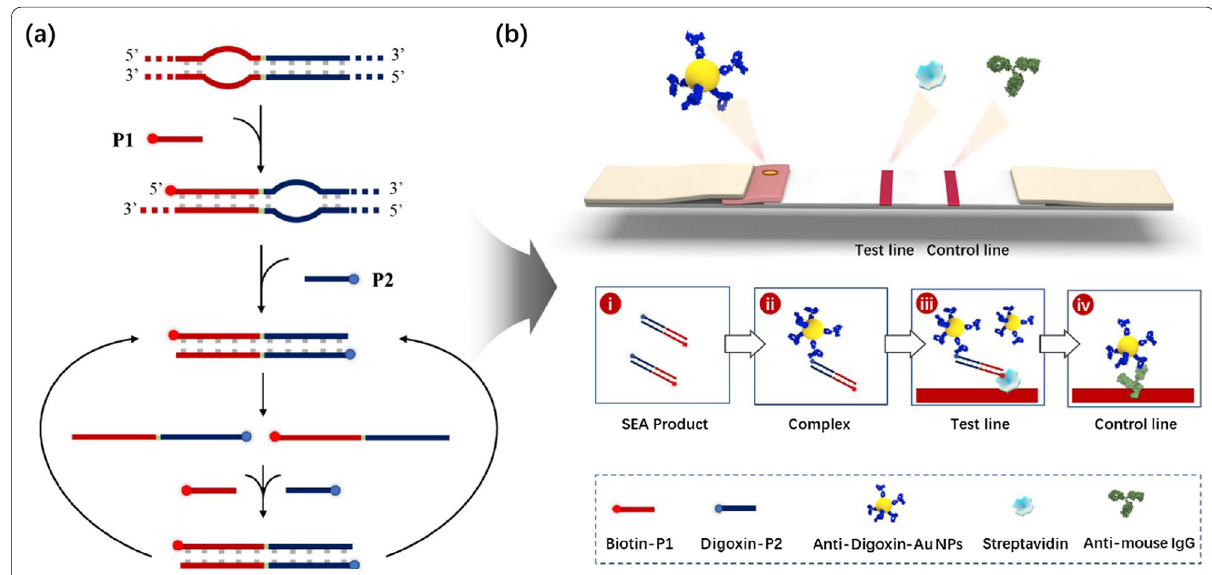
Fig. 6 Schematic illustration of the SEA-LFA strip for the detection of nucleic acids